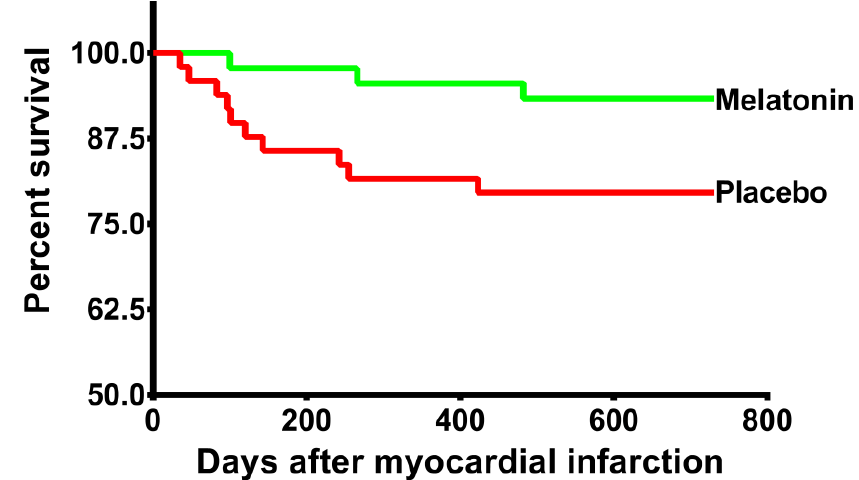
Figure 2. Kaplan–Meier curves: The Kaplan–Meier curves show the cumulative incidence of the primary endpoint, which was a composite of death and heart failure readmission at 2 years.